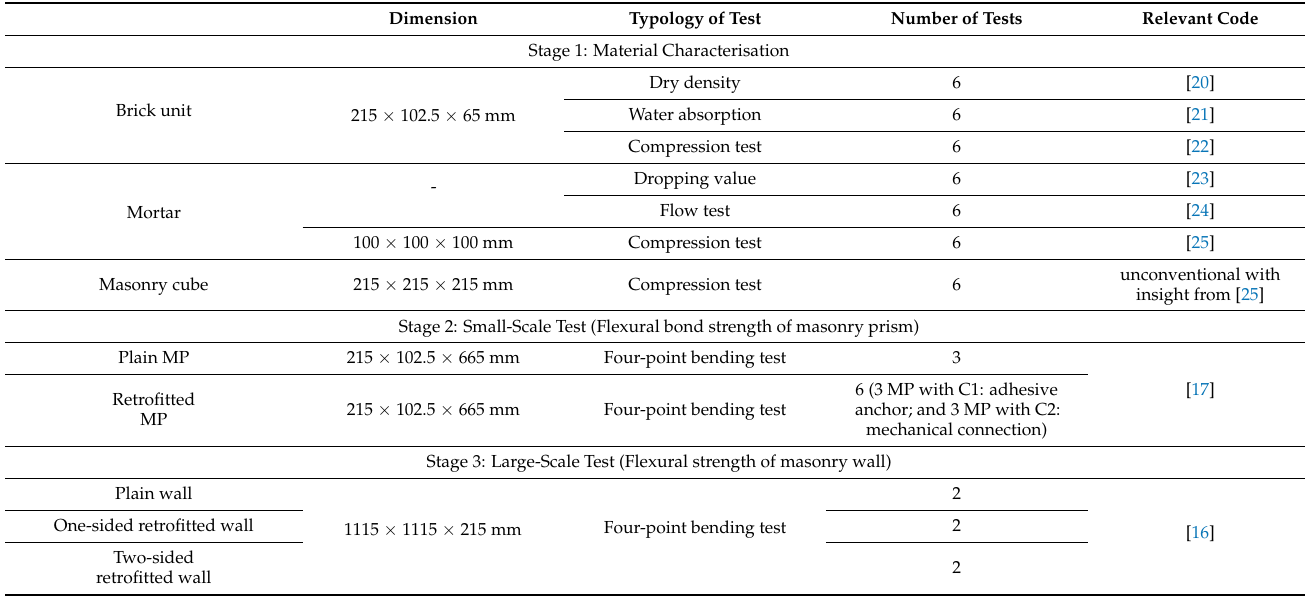
Table 1. Full experimental